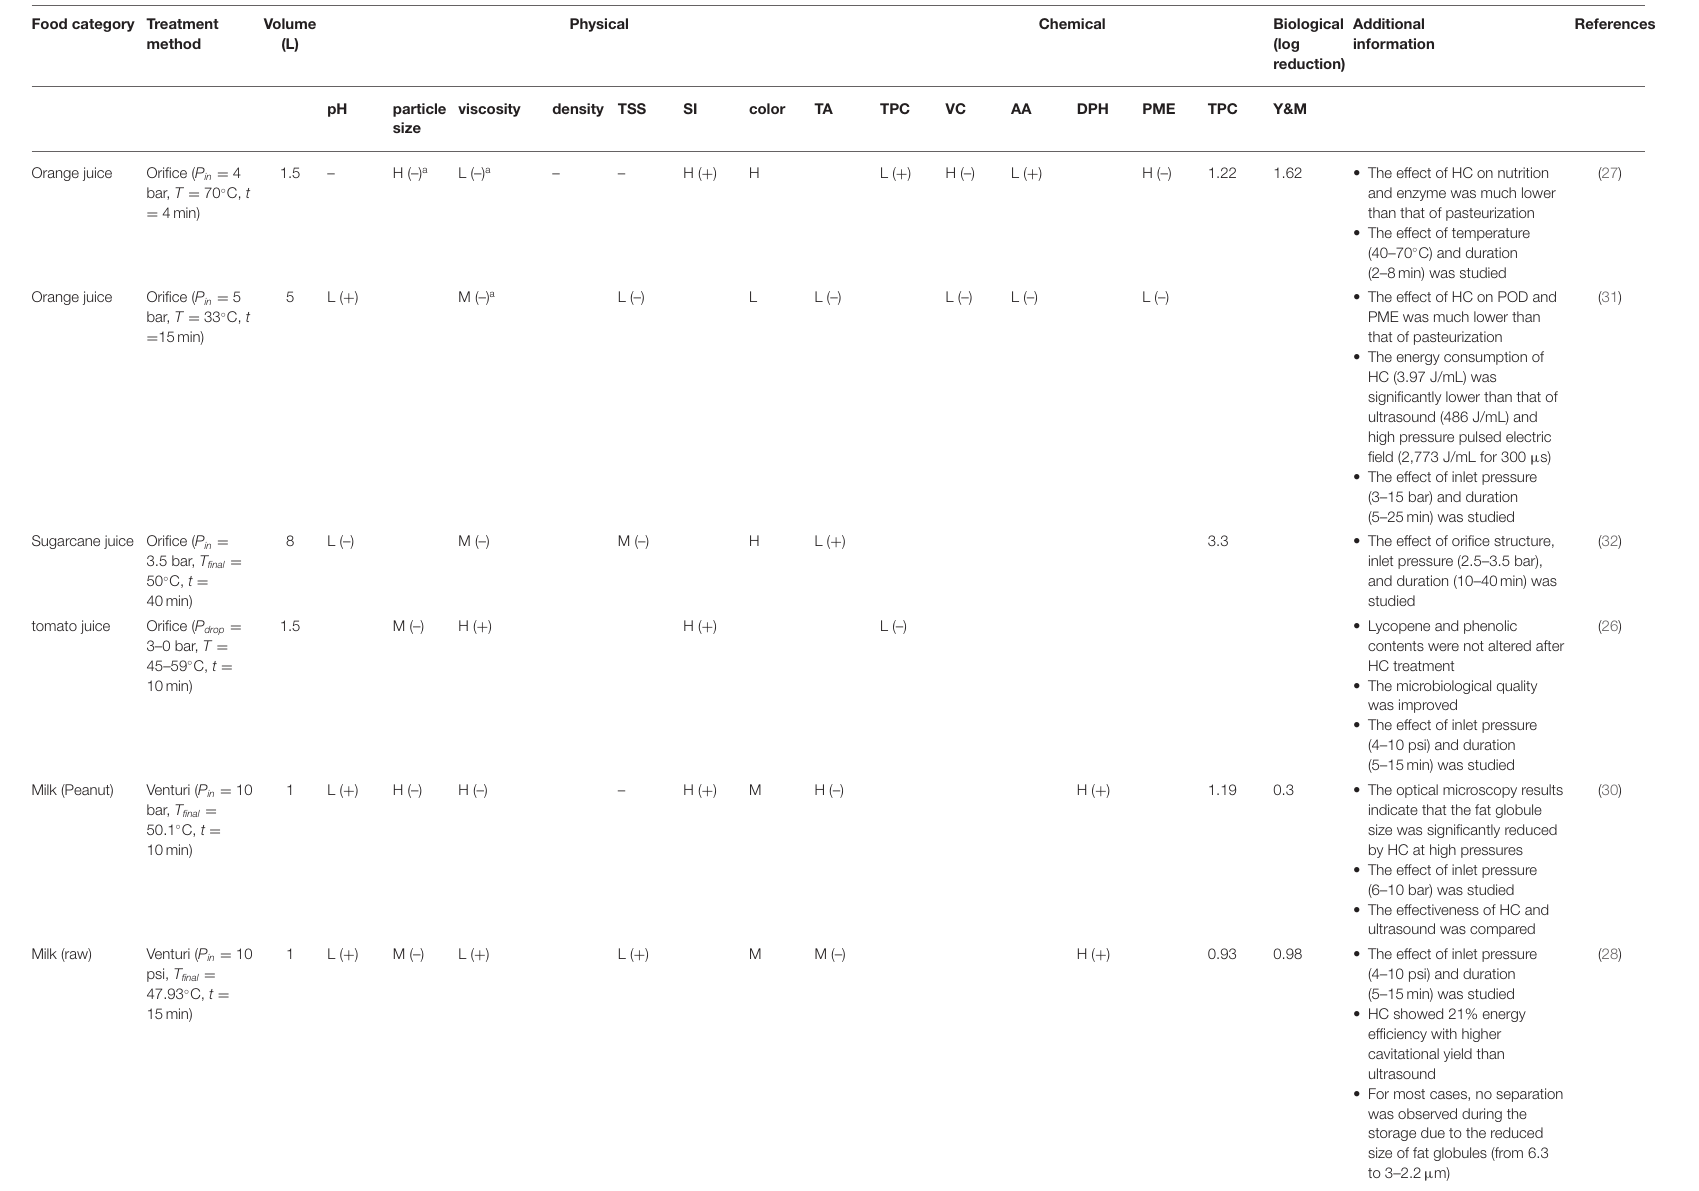
TABLE 1 | Overview of recent literature on the food processing by hydrodynamic cavitation (HC) (TSS, total soluble solid; SI, sedimentation index; TA, titratable acidity; TPC, total phenolic content; VC, vitamin C; AA, antioxidant activity; DPH, degree of protein hydrolysis; PME, pectin methyl esterase; TPC, total plate count; Y&M, yeast and molds). Food category Treatment